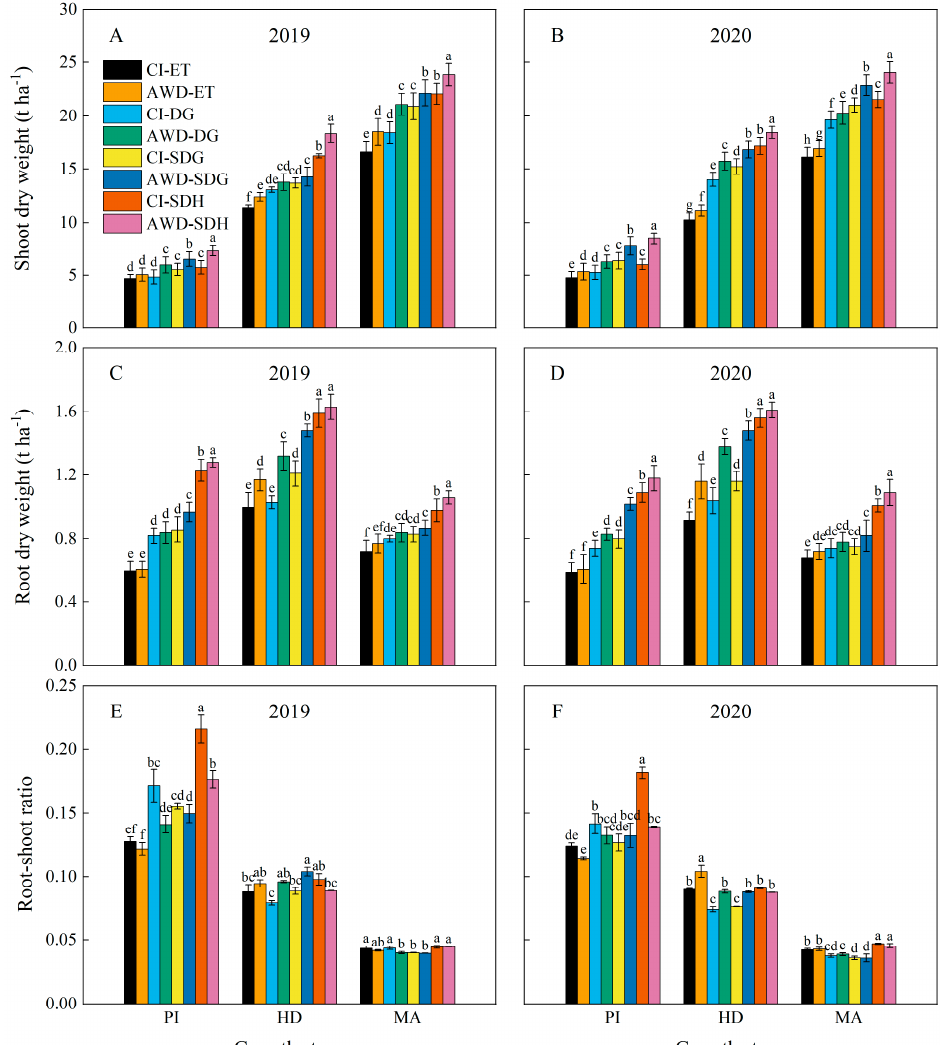
Figure 4. Shoot dry weight ( A , B ), root dry weight ( C , D ), and root–shoot ratio ( E , F ) at three growth stages of mid-season indica rice genotypes under different irrigation treatments. CI and AWD represent conventional irrigation treatment and alternate wetting and drying irrigation treatments, respectively. ET denotes early tall genotype, DG denotes dwarf genotype, SDG denotes semi-dwarf genotype, and SDH denotes semi-dwarf hybrid. PI, HD, and MA present panicle initiation, heading, and maturity, respectively. Vertical bars represent ± standard error of the mean where these exceed the size of the symbol. Different letters above the columns indicate significant differences ( p ≤ 0.05) within the same measurement time.